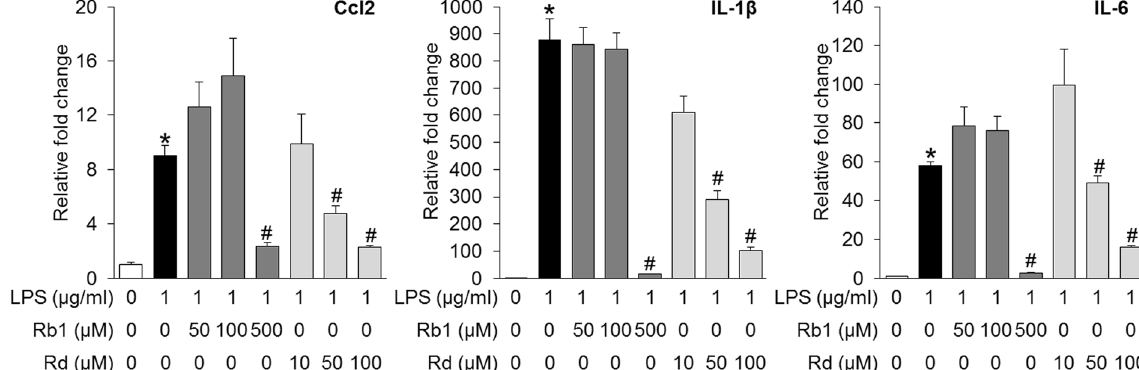
Figure 8. Rb1 or Rd treatment suppressed LPS-stimulated expression of proinflammatory genes in ARPE19 cells. Rb1 or Rd was applied to ARPE19 cells at the indicated concentrations 30 min before LPS stimulation delivered at 1 μ g/ml for 6 h. Total RNA was extracted for analyzing the expression of Ccl2, IL-1 β and IL-6 by real-time PCR (n = 4 per group). The data were expressed as the mean ± S.E.M. * Compared to that from vehicle-treated cells without LPS, p < 0.05; # compared to that from vehicle-treated cell with LPS stimulation, p <